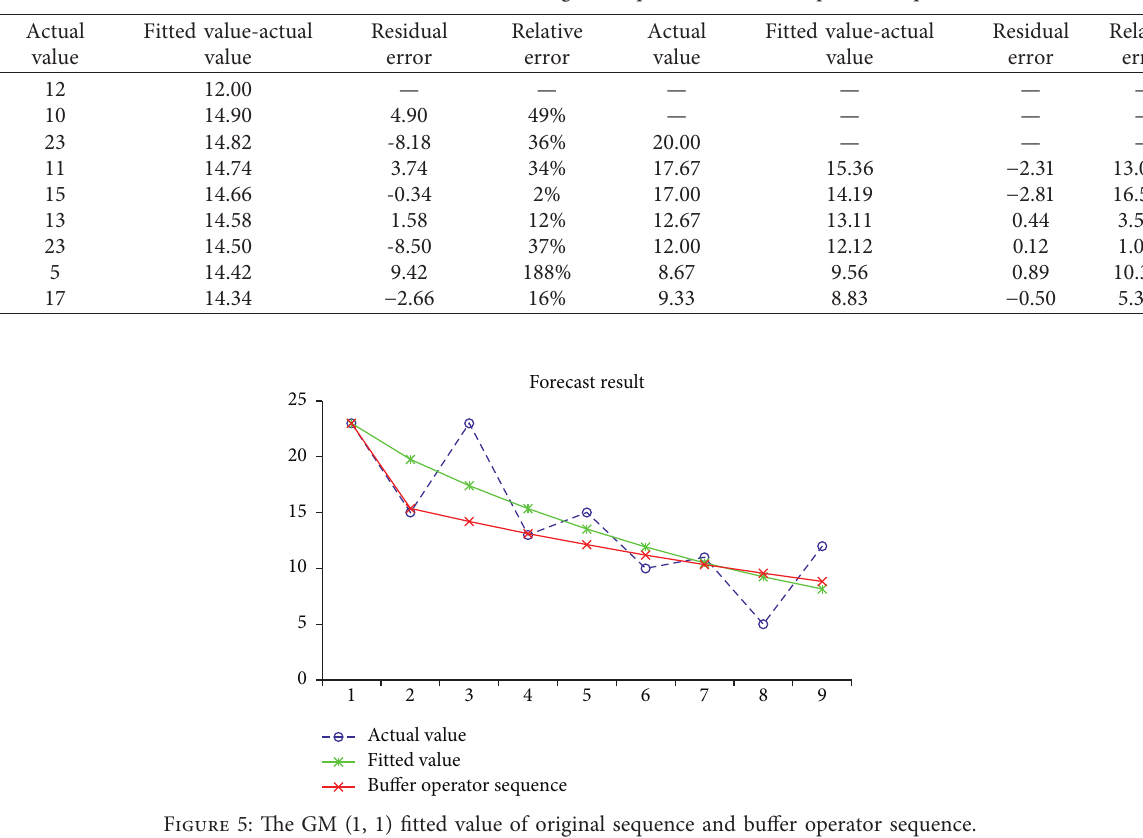
Table 10: The GM (1, 1) fitted value of original sequence and buffer operator sequence.